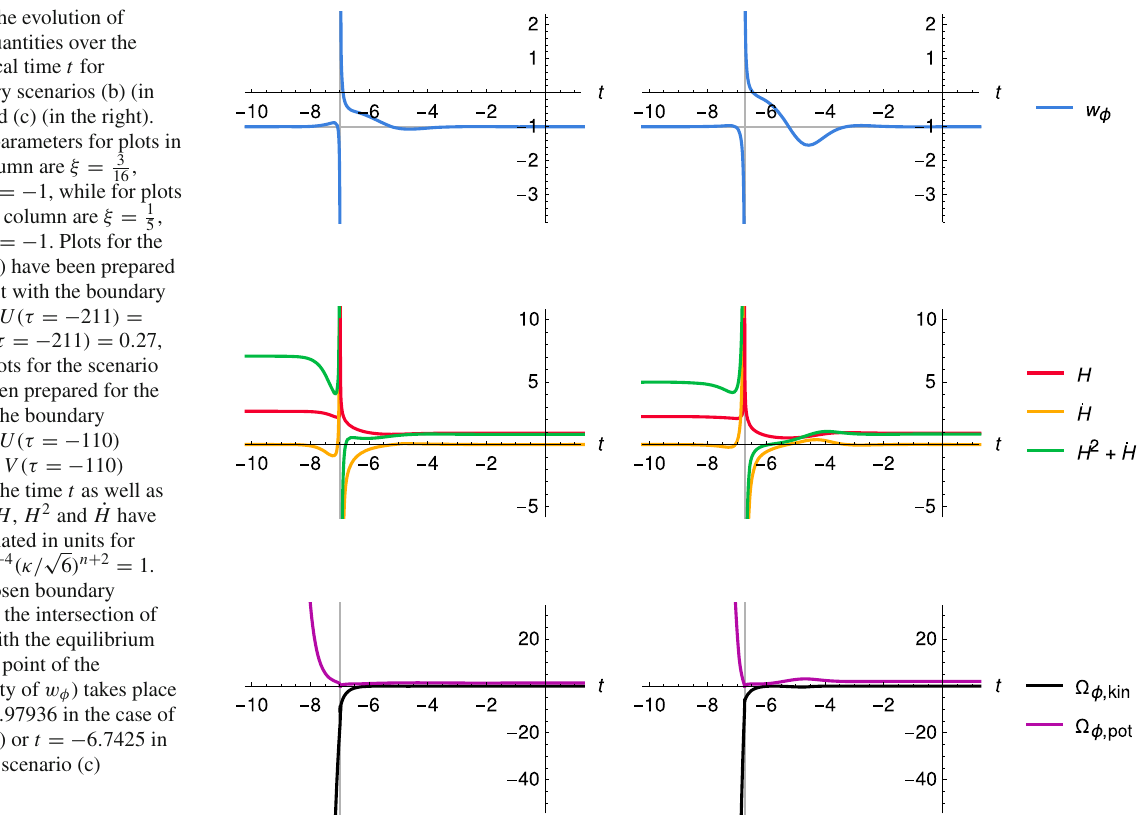
Fig. 15 The evolution of physical quantities over the cosmological time t for evolutionary scenarios (b) (in the left) and (c) (in the right). Values of parameters for plots in the left column are ξ = 3 , 16 n = − 1, ε = − 1, while for plots in the right column are ξ = 1 , 5 n = − 2, ε = − 1. Plots for the scenario (b) have been prepared for the orbit with the boundary conditions U (τ = − 211 ) = − 0 . 75, V (τ = − 211 ) = 0 . 27, whereas plots for the scenario (c) have been prepared for the orbit with the boundary conditions U (τ = − 110 ) = − 0 . 767, V (τ = − 110 ) = 0 . 322. The time t as well as quantities H , H 2 and ˙ H have been calculated in units for √ which M n + 4 (κ/ 6 ) n + 2 = 1. For the chosen boundary conditions, the intersection of the orbit with the equilibrium line F (the point of the discontinuity of w φ ) takes place for t = − 6 . 97936 in the case of scenario (b) or t = − 6 . 7425 in the case of scenario